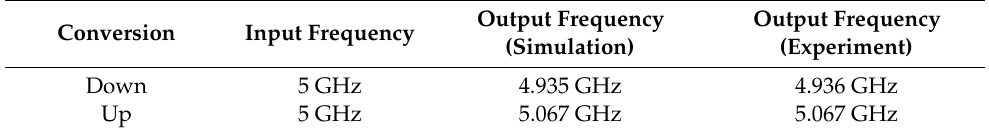
Table 1. The comparison of the down-conversion and up-conversion frequencies between the simulations and the experiment results.